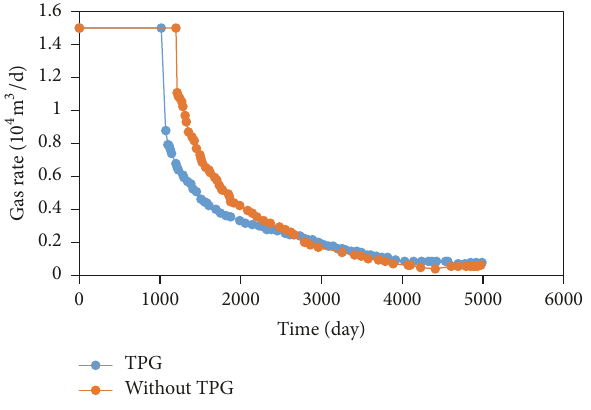
Figure 7: Effect of TPG on gas production.